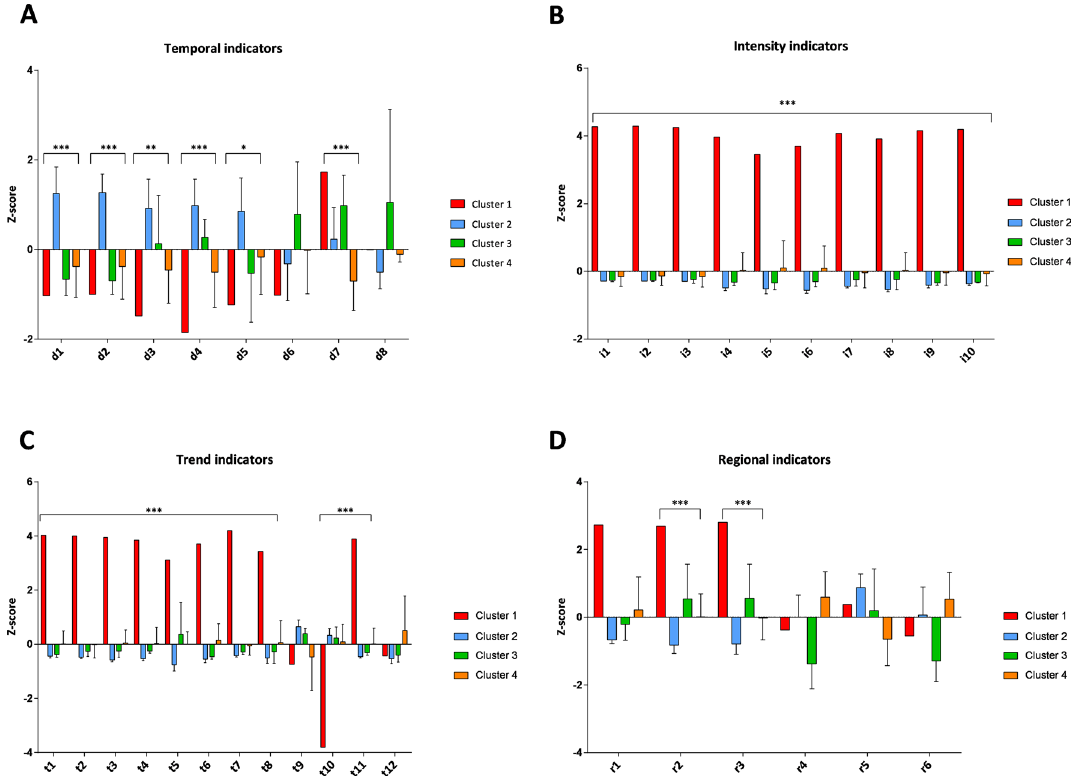
Figure 2. Comparison of SARS-CoV-2 epidemic indicators by clusters. This panel show the one-way analysis of variance (ANOVA) of temporal ( A ), intensity ( B ), trend ( C ), and regional ( D ) indicators across clusters. Statistical analysis was conducted after z-score standardization, and hence results can be interpreted as deviation from the national average. *p < 0.001; **p < 0.0001; ***p <